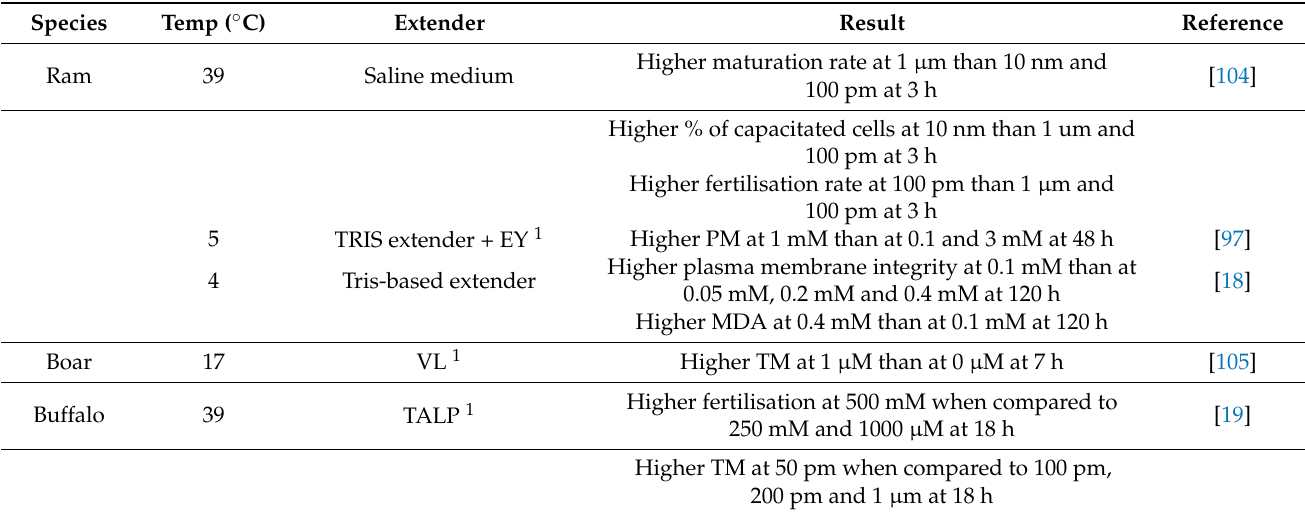
Table 6. Summary of noteworthy results on melatonin supplementation (Mel) for semen storage above 5 ◦ C in various